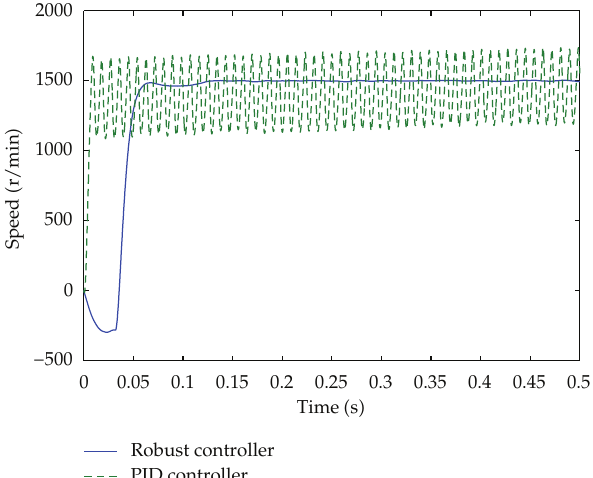
Figure 6: Speed response under the network delays and dropouts.